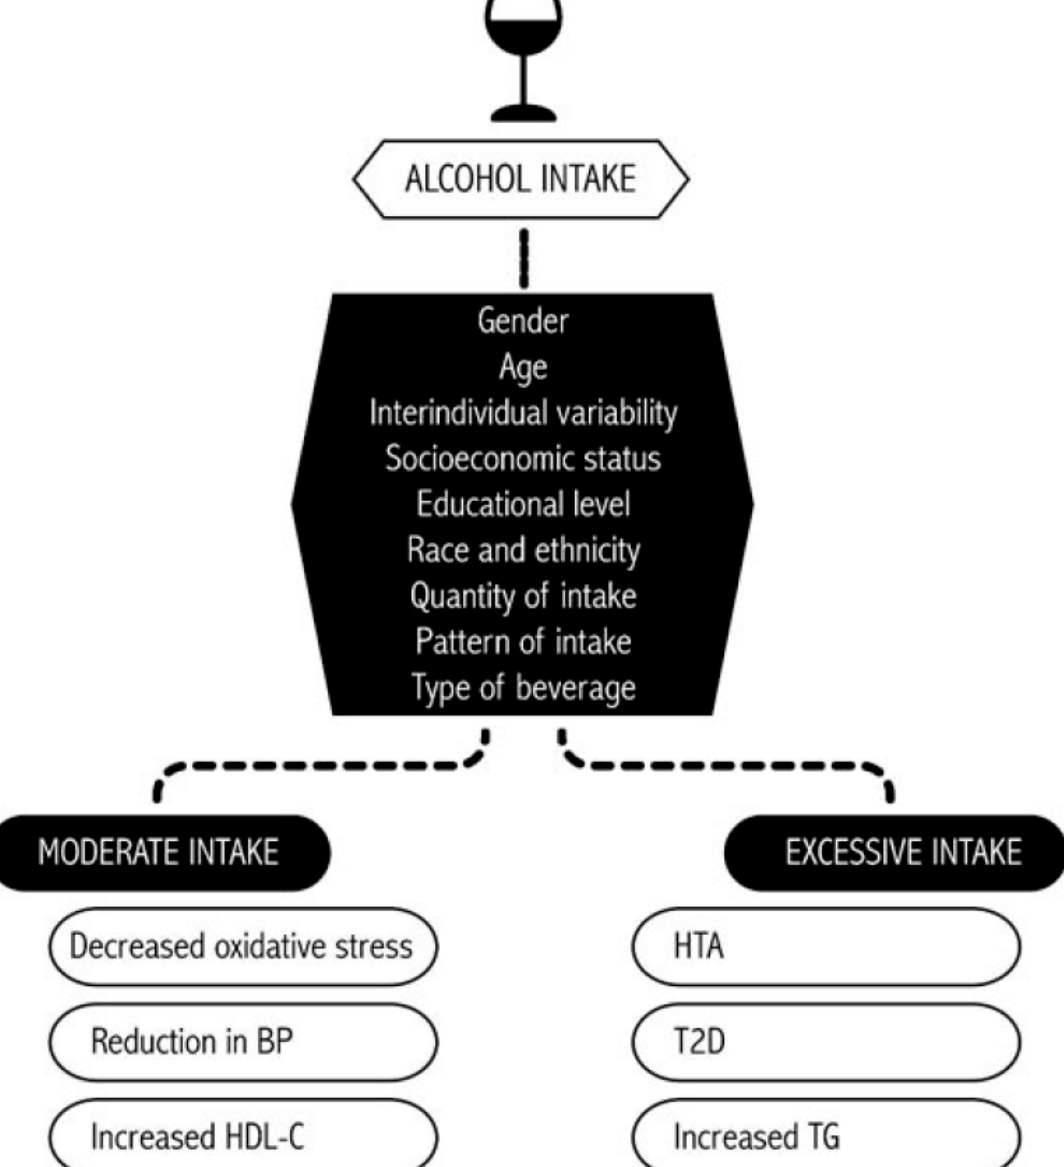
Figure 1. Alcohol’s health effects. BP, blood pressure; HDL-c, high-density lipoprotein cholesterol; HTA, hypertension; TG, triglycerides; T2D, type 2 diabetes.